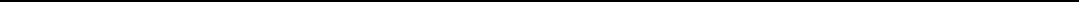
Fig. 1 Plk1 activates G6PD during cell cycle progression. a – c HeLa cells were synchronized into G1, S, and G2/M phases, and cells were harvested and subjected to western blot ( a ) and G6PD or 6PGD enzyme activity measurement ( b ), and NADPH and NADP + /NADPH ratio levels ( c ) at indicated time after release. n = 3 biologically independent replicates. Data were presented as mean ± s.d. * P < 0.05 as compared to G1 phase group by two-sided Student ’ s t -test. β -actin served as loading control. d – f HeLa cells were synchronized at G0/G1 phase with double HU block. The G6PD activity ( d ), and NADPH and NADP + /NADPH ratio levels ( e ) were measured in the presence or absence of 1 μ M Plk1 inhibitor BI2536 at indicate hours after release. FACS analysis of cell cycle progression was shown in f . n = 3 biologically independent replicates. Data were presented as mean ± s.d. * P < 0.05 as compared to 0 h group, # P < 0.05 as compared to DMSO group by two-sided Student ’ s t -test. g , h HeLa cells were transfected with empty vector (EV) or gradual amount of Flag-Plk1 plasmids. Cells were harvested and subjected to western blot and G6PD activity measurement ( g ), and NADPH and NADP + /NADPH ratio levels ( h ). n = 3 biologically independent replicates. Data were presented as mean ± s.d. * P < 0.05 as compared to EV group by two-sided Student ’ s t